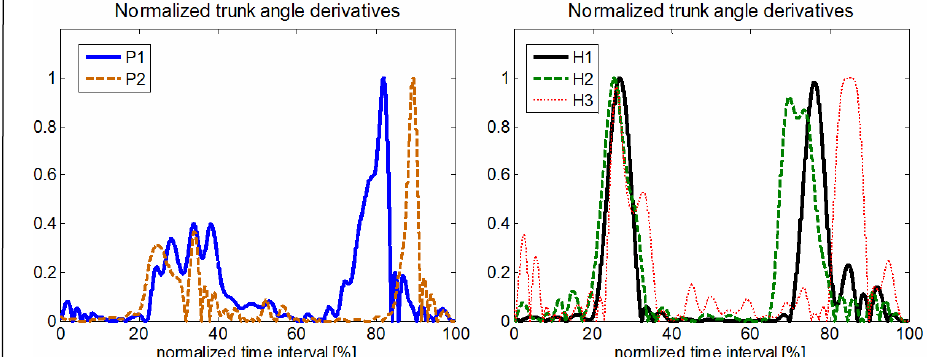
Figure 4 – Normalized trunk angle derivatives for 2 patients P1 and P2 (left-hand panel) and for three healthy subjects H1, H2, and H3 (left-hand panel). Slika 4 – Normalizovani derivativi uglova trupa za dva pacijenta P1 i P2 (levi panel) i za tri zdrava subjekta H1, H2 i H3 (desni